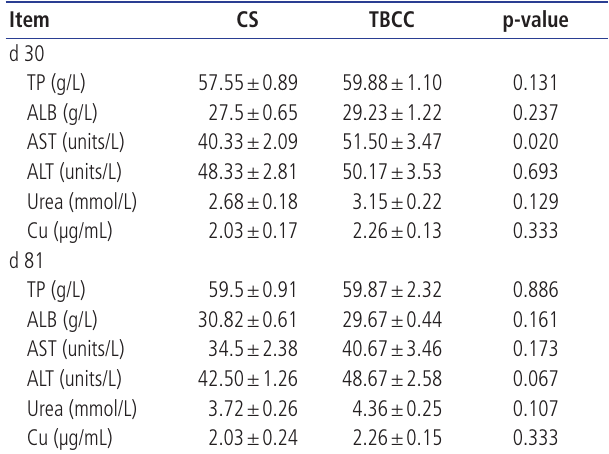
Table 3. Effect of copper sulfate (CS) and tribasic copper chloride (TBCC) on the physiochemical parameters and Cu concentration in serum of pigs Item CS TBCC